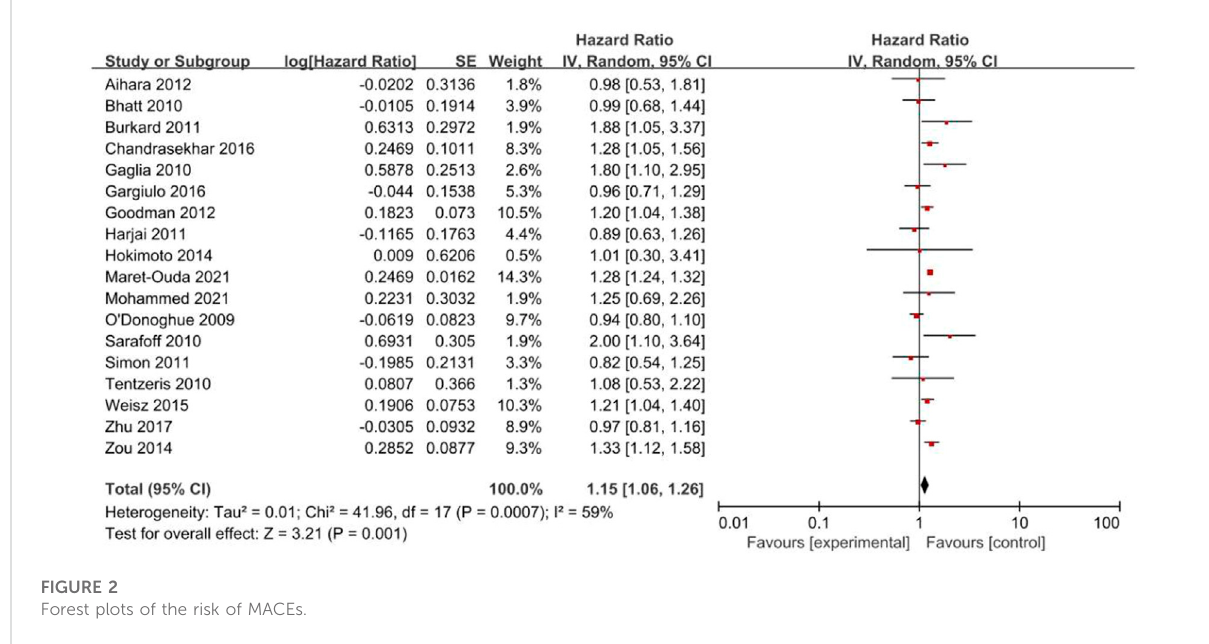
FIGURE 2 Forest plots of the risk of MACEs.